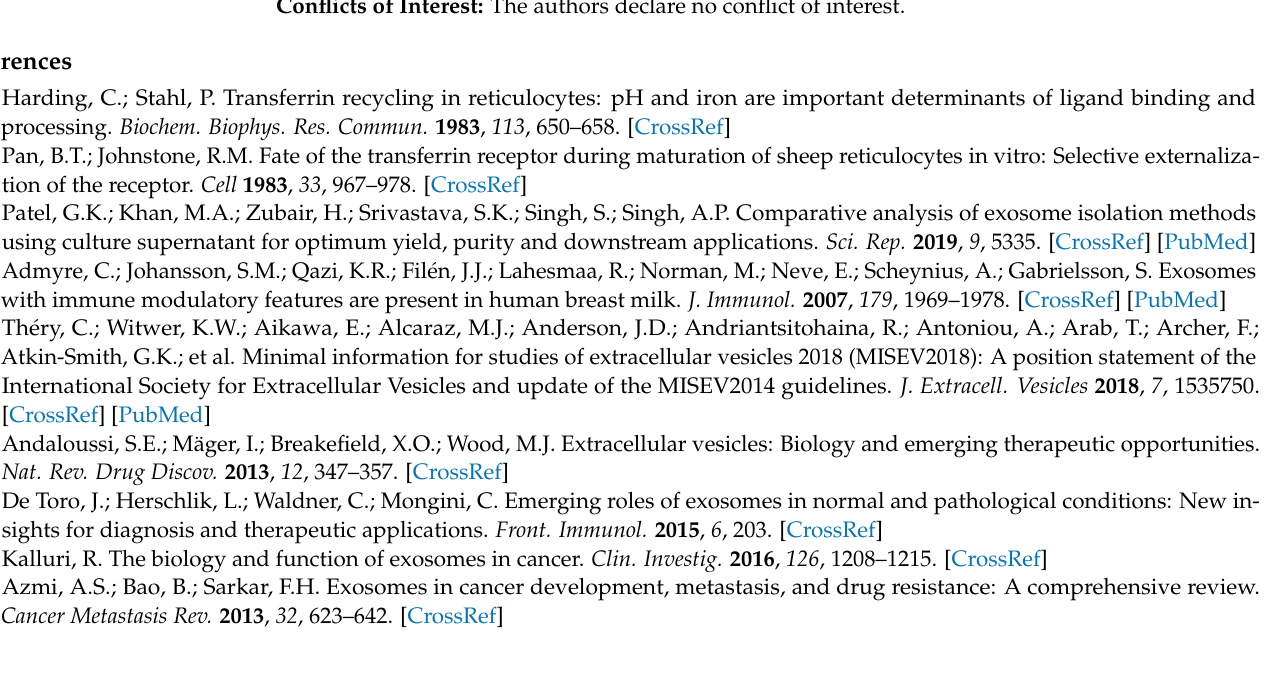
plasma. Figure S2: Comparison of EV isolation performance for two different bead